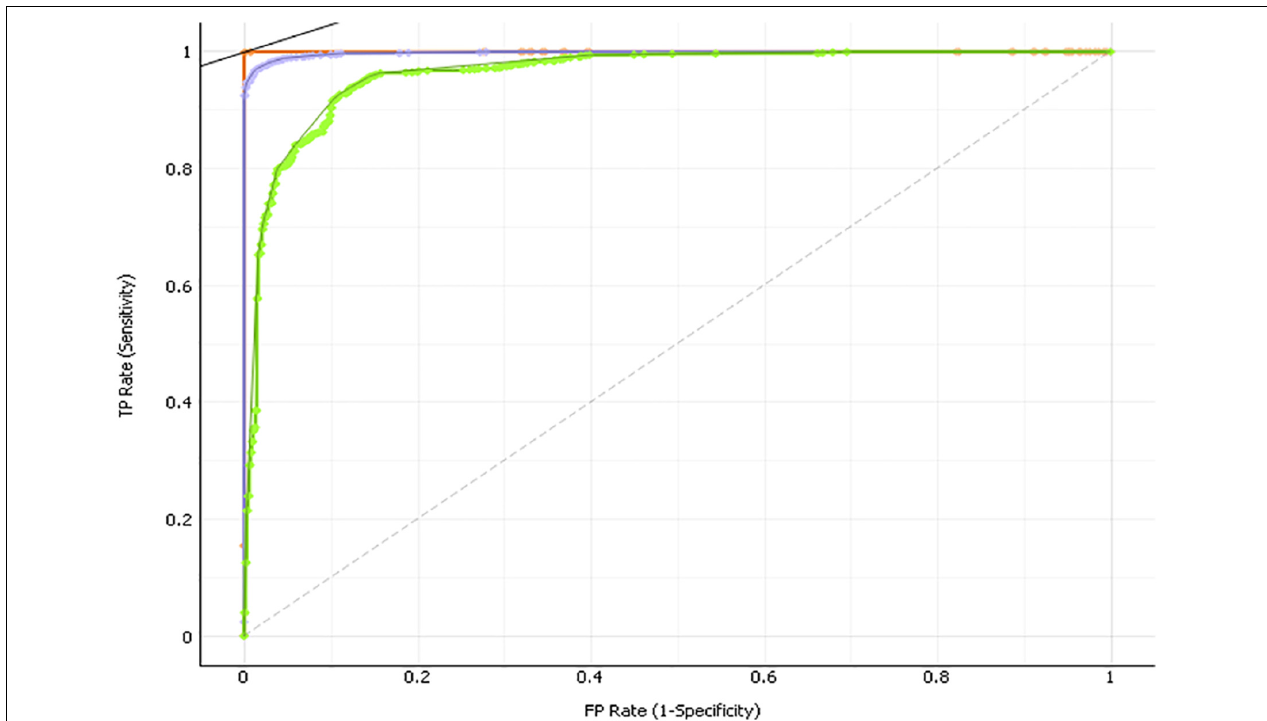
FIGURE 3 | Results of feature importance and ROC curves reflecting the predictive accuracy using machine